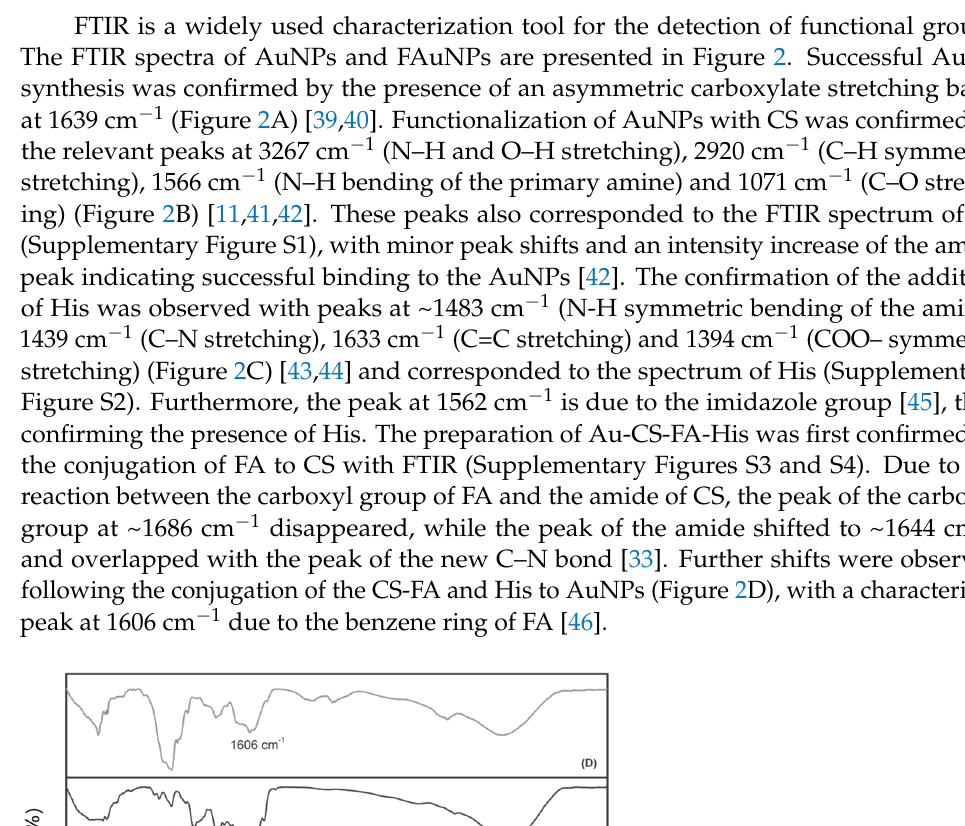
Figure 3. HRTEM images of ( A ) AuNPs, ( B ) Au-CS, ( C ) Au-CS-His and ( D ) Au-CS-FA-His. Scale bar = 100 nm. The nanoparticle tracking analysis (NTA) is a characterization technique that tracks the movement of individual particles in a solution to determine the average hydrody- namic diameter [47]. The sizes of the NPs and nanocomplexes are reflected in Table 2. The AuNPs were found to have a hydrodynamic diameter of 79.9 nm, and, following the func- tionlization of the AuNPs, an increase in size was observed. This increase is consistent with the red shifts in λ max observed by UV–Vis spectrophotometry. A change in NP size after surface modification is considered an indication of successful functionalization [48,49]. Furthermore, it was observed that the size of the nanocomplex increased